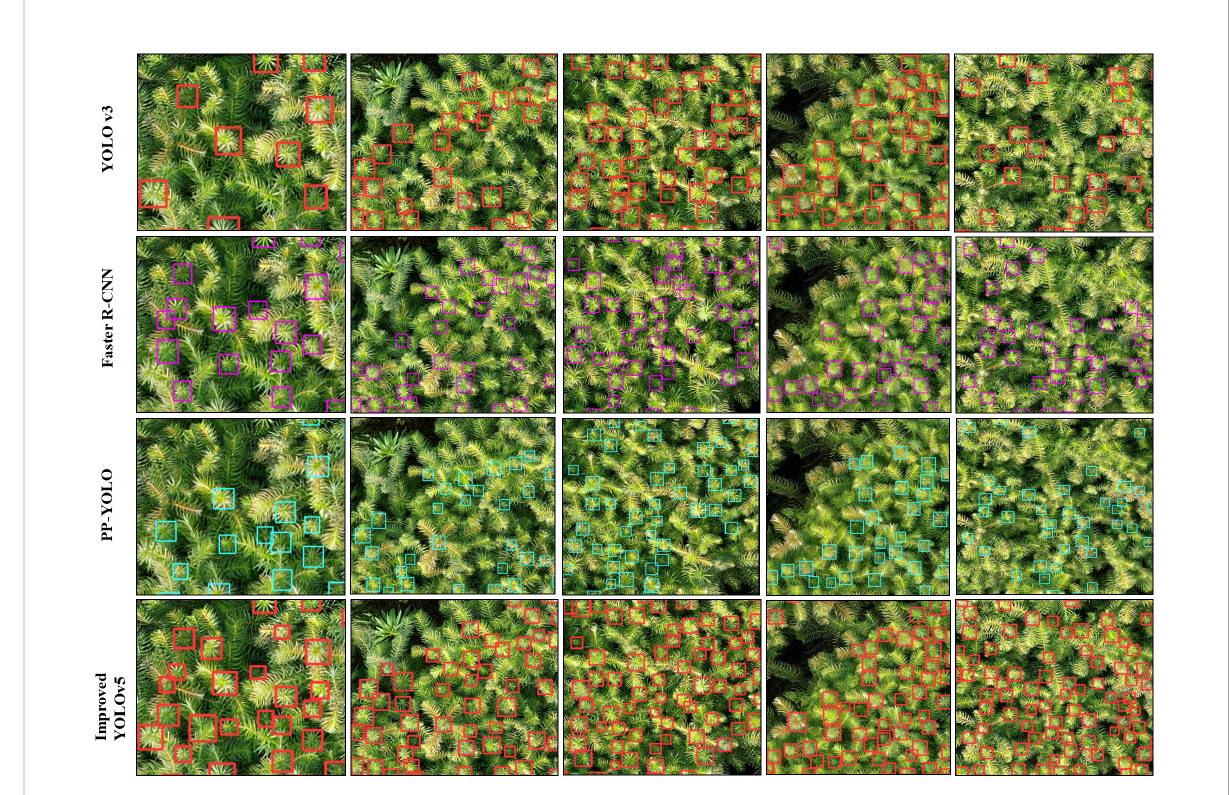
FIGURE 14 Comparison of recognition of the terminal bud of Chinese fi r seedlings for different